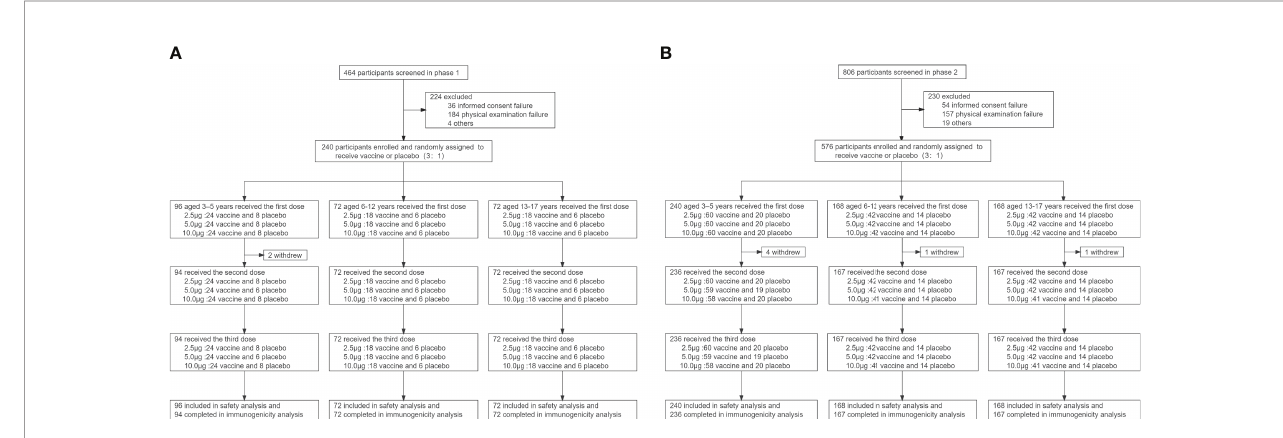
FIGURE 1 | Trial pro fi le for phase 1 (A) and phase 2 (B)